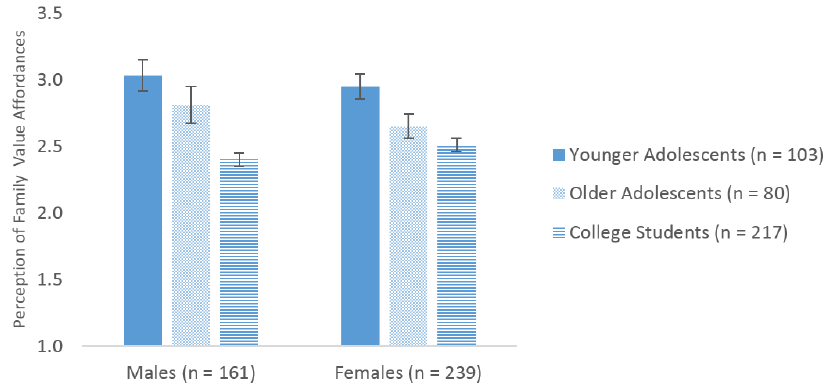
Figure 1. Perception that science affords family goals by gender and age group. Table 1. Study 1: Means and Standard Deviations for Dependent Variables by Gender and Age Group.